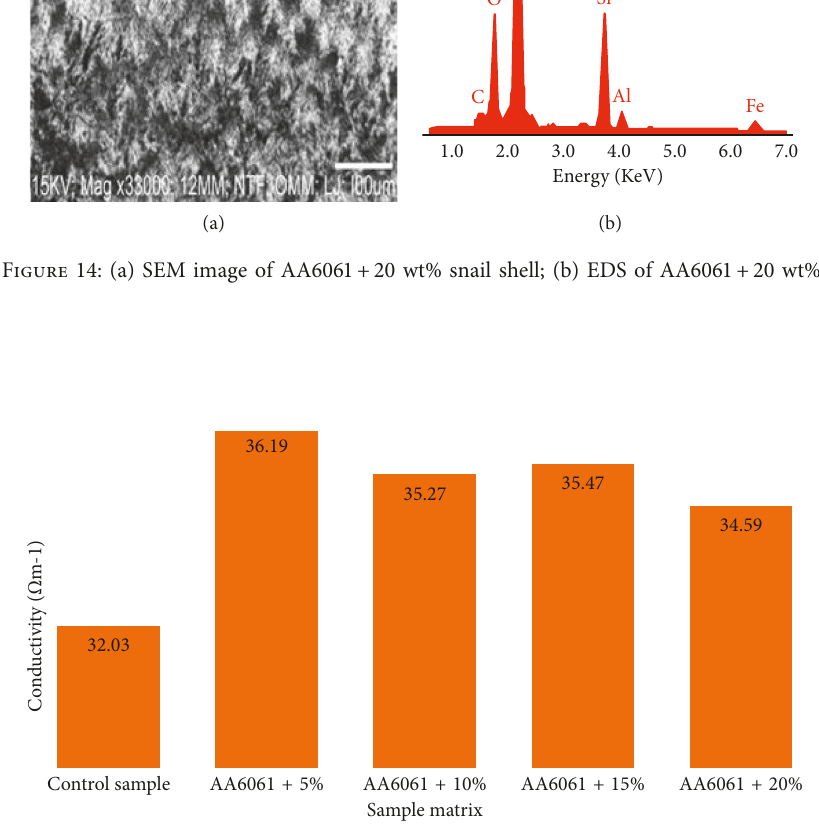
Figure 15: Effect of snail shells on the conductivity of the reinforced aluminium composite.